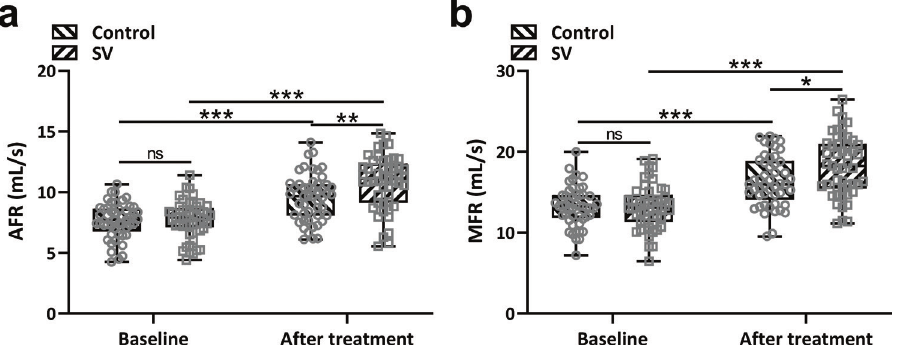
Fig. 2 . Comparisons of average flow rate (a) and maximum flow rate (b) between the two groups before and after treatment. N = 49 for each group. Data were shown with box plot. * P < 0.05, ** P < 0.01, *** P < 0.001, and ns means no significance. Two-way ANOVA followed Turkey’s multiple comparisons